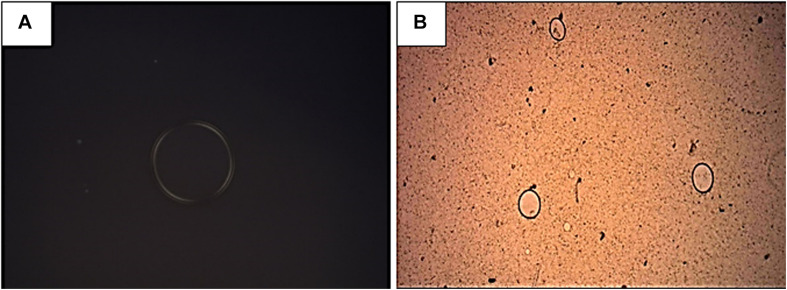
Photomicrograph of the nanostructured lipid system (NLS) in dark field (A) and of the system incorporated with nonyl protocatechuate (NLS + nonyl) in bright field (B), in 4X magnification. An isotropy of the samples can be observed, suggesting formation of the micro-emulsified system.